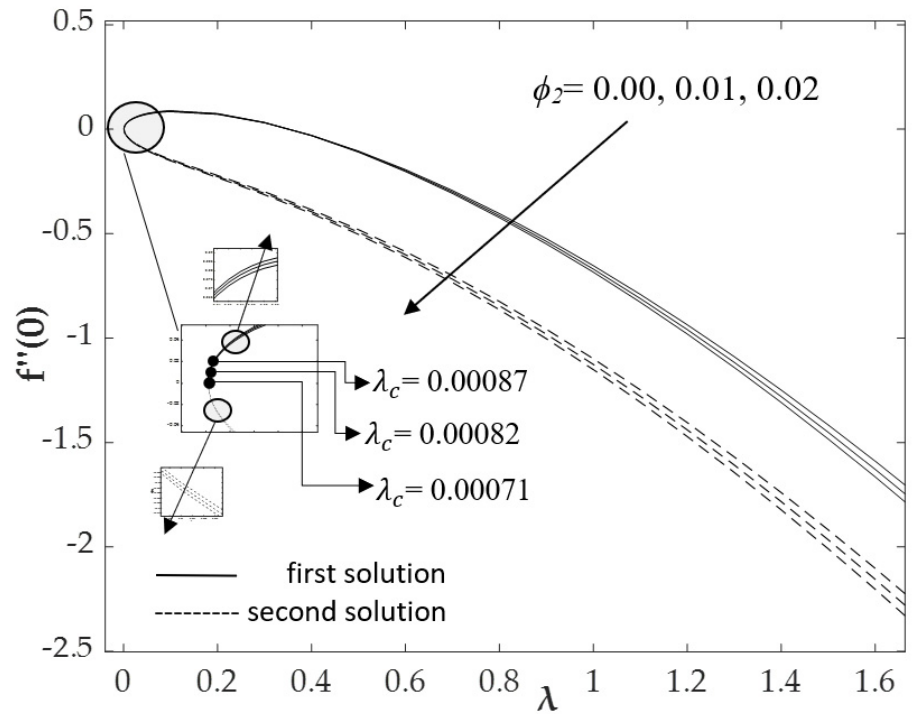
( ) 0 f ′′ , with stretching param-